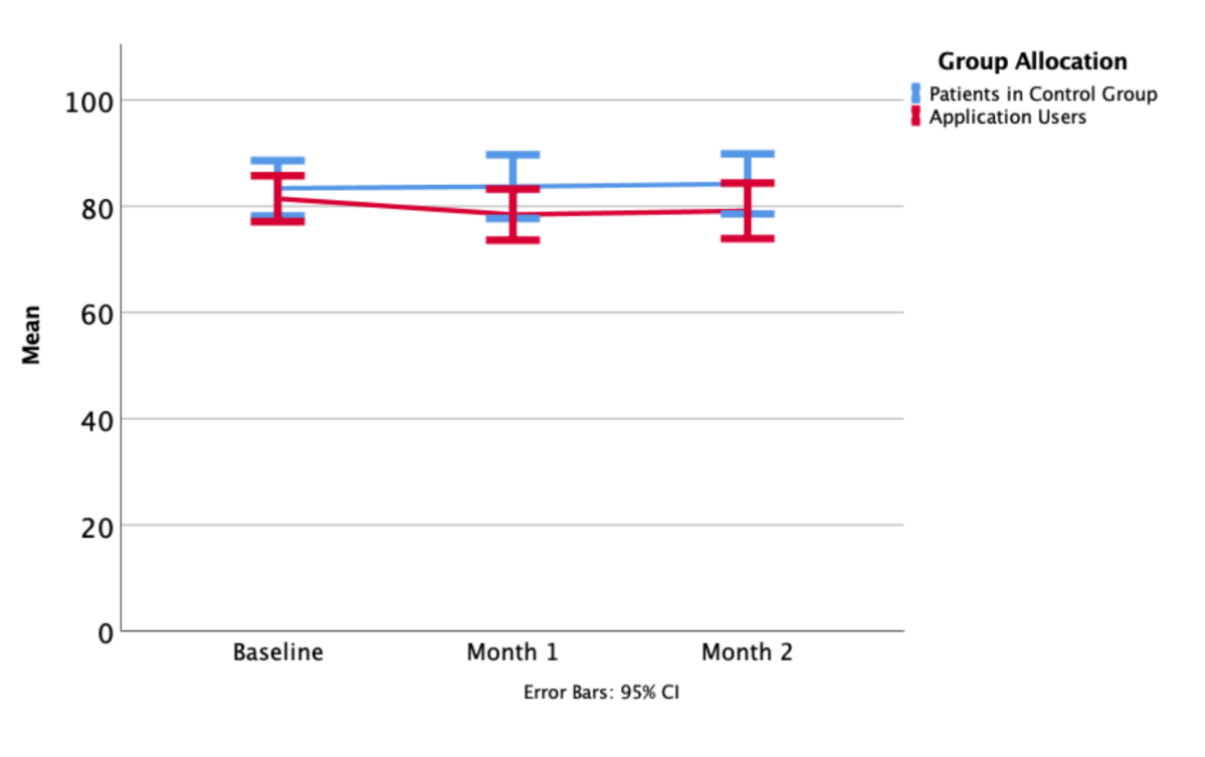
Figure 4. General version of the Functional Assessment of Cancer Therapy (FACT-G) overall means at baseline, one month, and at the end of the study period.